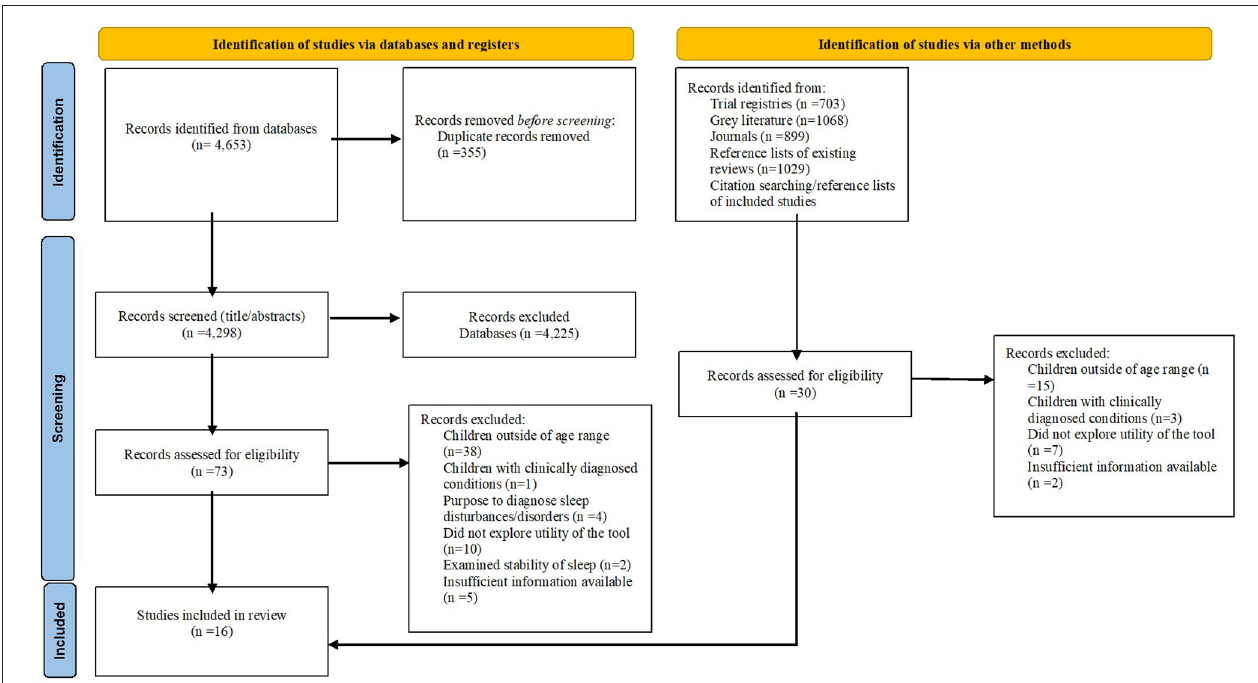
FIGURE 1 | PRISMA flow chart of included studies